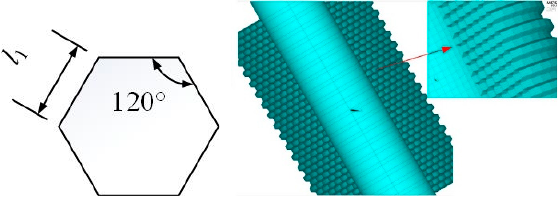
Figure 2. Honeycomb cell and section view of honeycomb reinforced pipe structure [15].